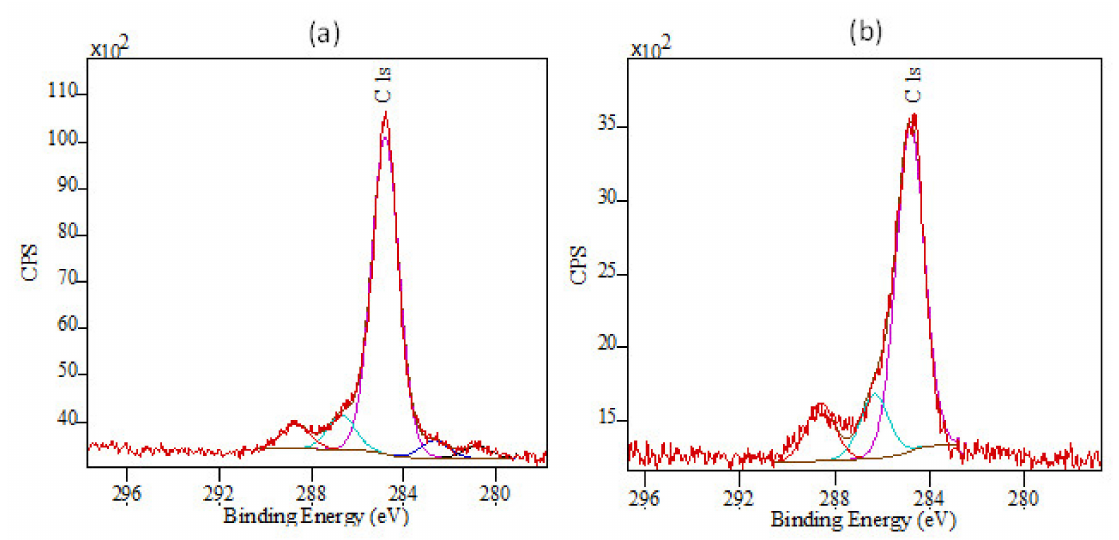
Figure 6. AFM image of GaN sample grown under slightly gallium-rich conditions with 200 pulse cycles. RMS surface roughness of 0.24 nm.